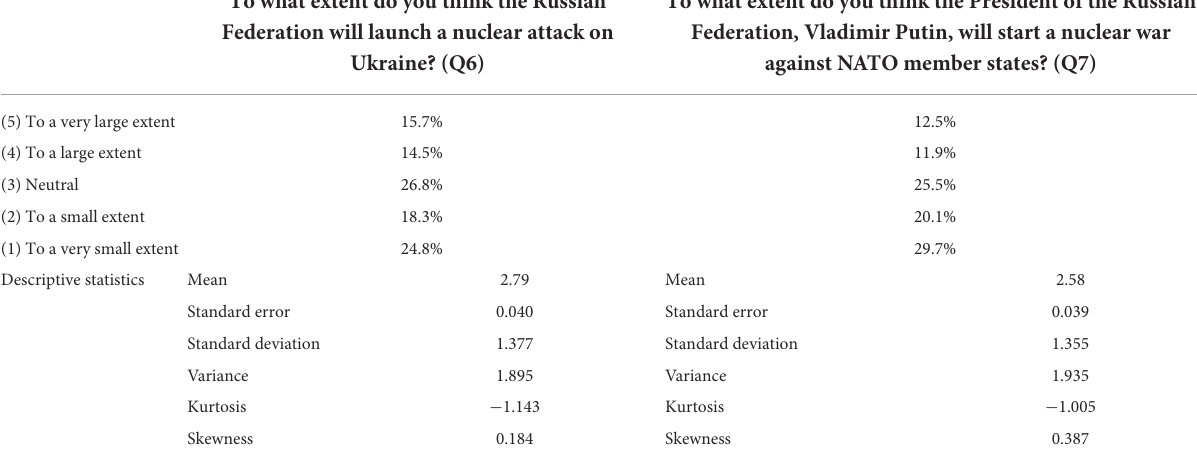
TABLE 5 Participants’ opinion on a possible nuclear attack launched by the Russian Federation on Romania or another NATO member state.